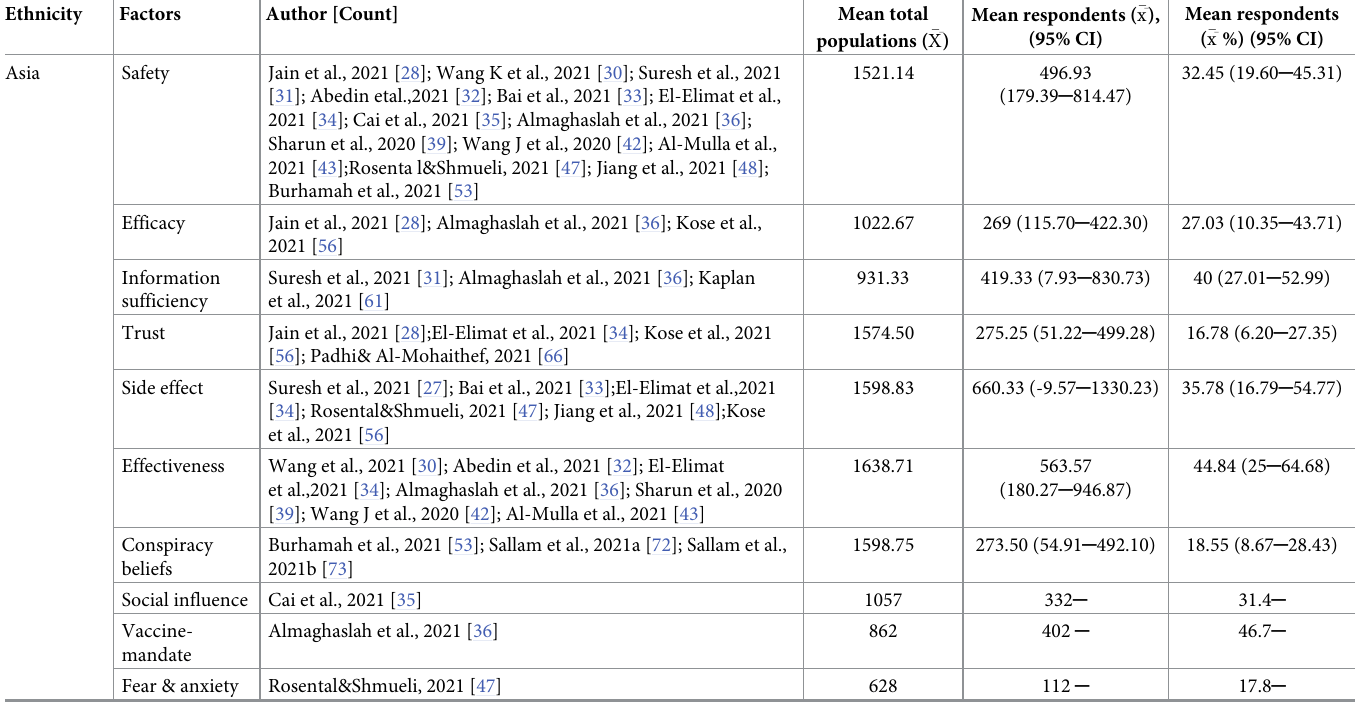
Table 2. Distribution of potential factors across different